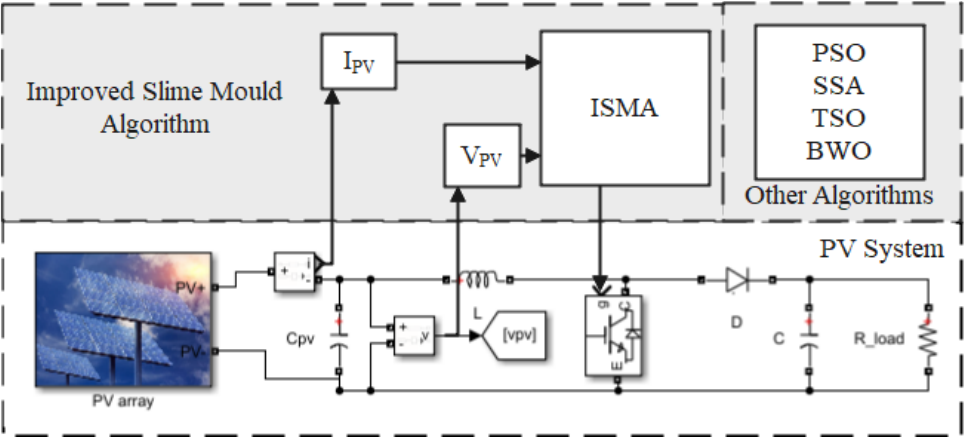
Figure 5. Control block diagram of the improved slime mold algorithm.